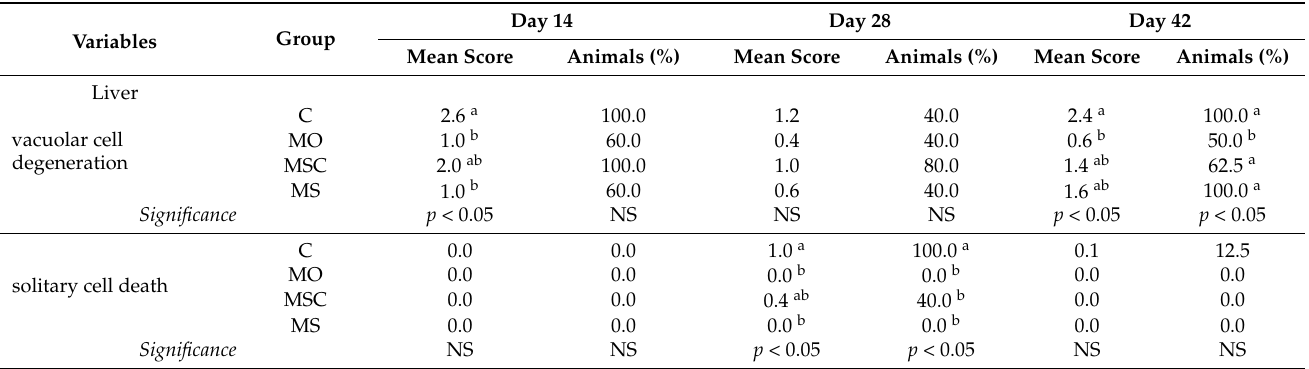
Table 4. Effect of dietary treatments on histopathology of liver, spleen, and bursa of Fabricius of